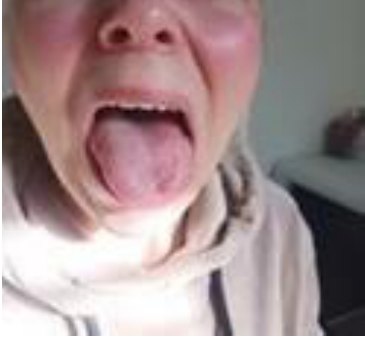
Figure 7. The patient’s photo three months later (April 2021).